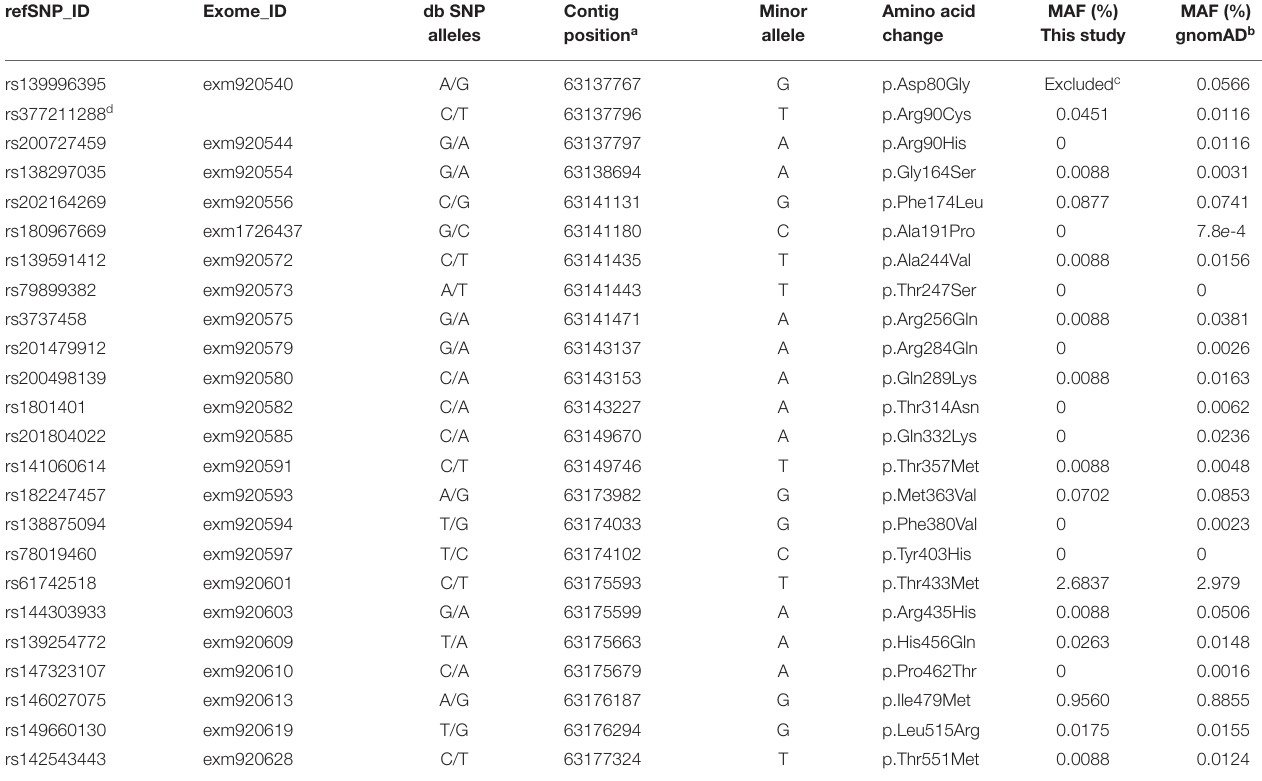
TABLE 2 | Minor allele frequencies (MAF) and other annotations of the SLC22A9 genetic variants assessed by the Illumina ExomeChip array or KASP TM sequencing in the SHIP and SHIP-TREND study cohort in comparison to the data for non-Finnish Europeans from the Genome Aggregation Database